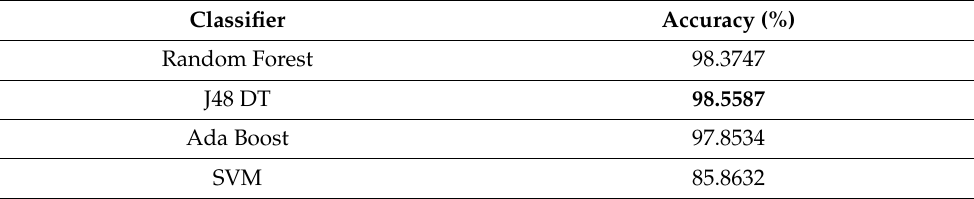
Table 5. Comparative results for the classifiers.